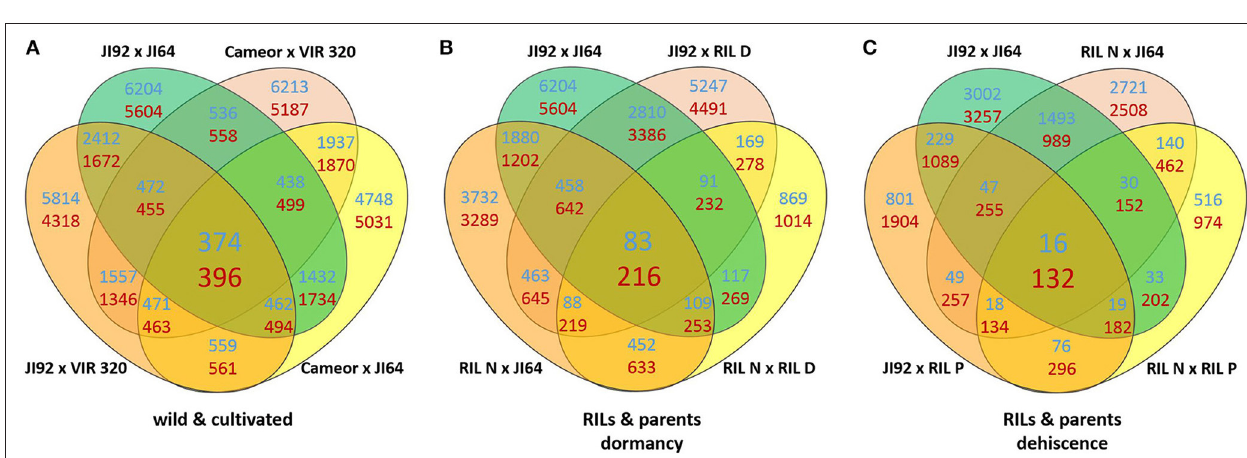
FIGURE 7 | Venn diagrams of differentially expressed genes (DEGs criteria log 2 FC ≥ 2 and FDR ≥ 0.01) between seed coat (A) of the studied wild and cultivated genotypes, (B) and JI64, JI92 parents and resulting RILs and (C) between pod sutures of JI64, JI92 parents and resulting RILs. Blue counts are upregulated and red counts are downregulated in cultivated